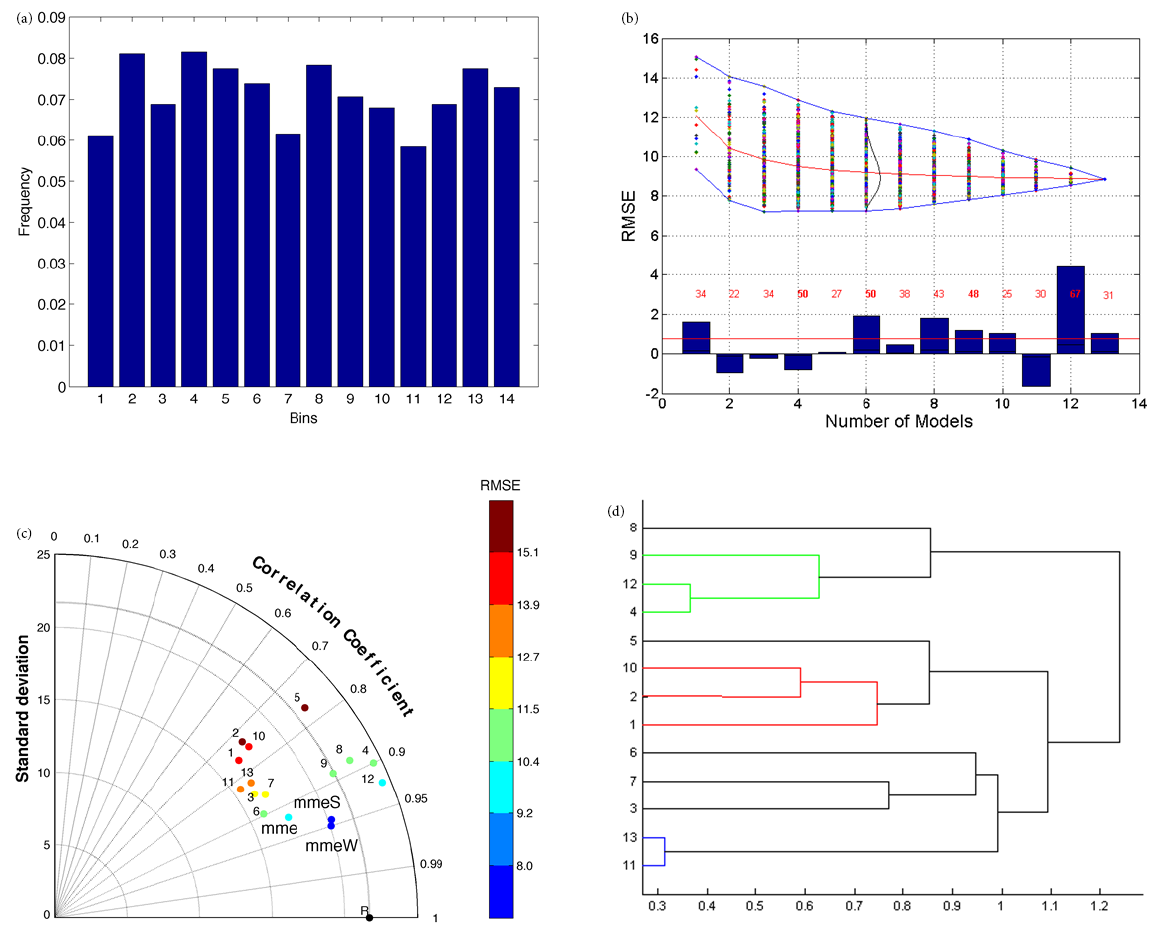
Figure 3. (a) Talagrand diagram of the full ensemble. (b) Ensemble error (RMSE) from all possible combinations of candidate models (EU4r). The notation is similar to Fig. 1. The numbers in red express the fractional contribution of each model to skilled combinations (top right). (c) Multiple aspects of individual model skill through Taylor plot. The point R on the x -axis represents the reference field (i.e. observations). (d) Clustering members with the corr( d i , d j ) matrix (bottom